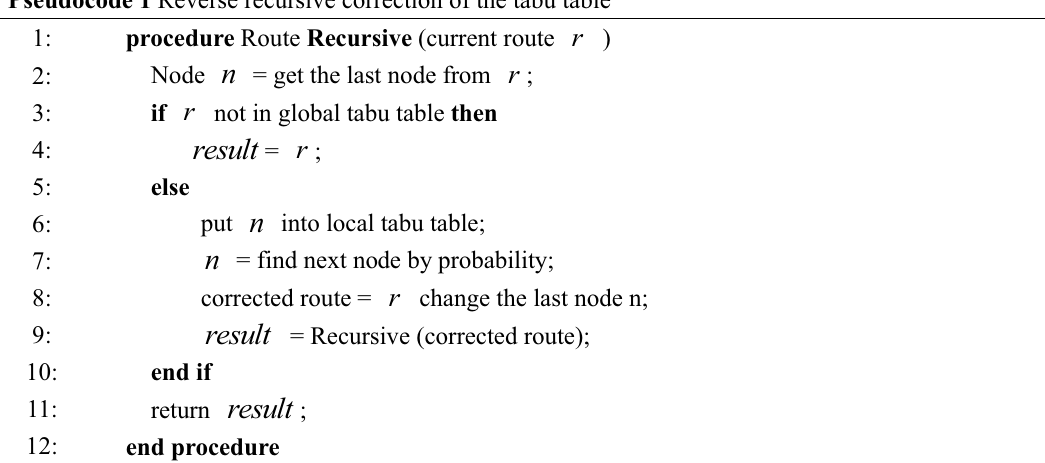
Algorithm description. Pseudocode 2 details the steps involved in the two-level nesting algorithm. Step1, initializes global tabu table, population size, iteration times and sets the pheromone concentration tuple. Setp2, calculates the node selection probability of the ant m by formula (14), and initializes the local tabu table.